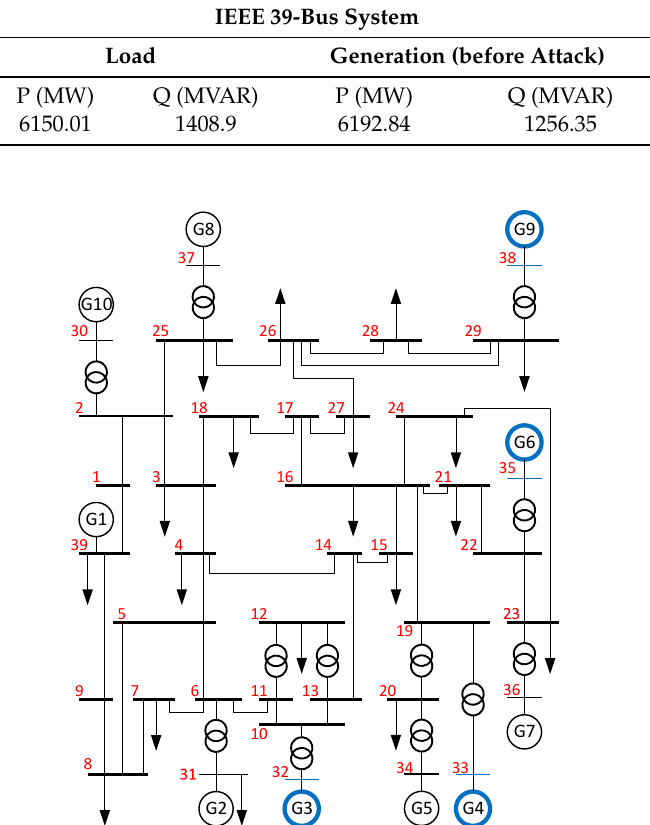
Table 6. Load and generation data of the IEEE 39 ‐ bus system.